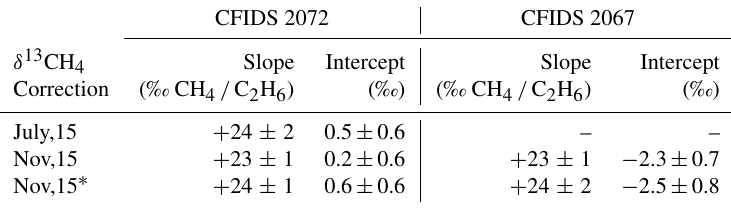
Table 3. The various response functions calculated for the δ 13 CH 4 correction due to C 2 H 6